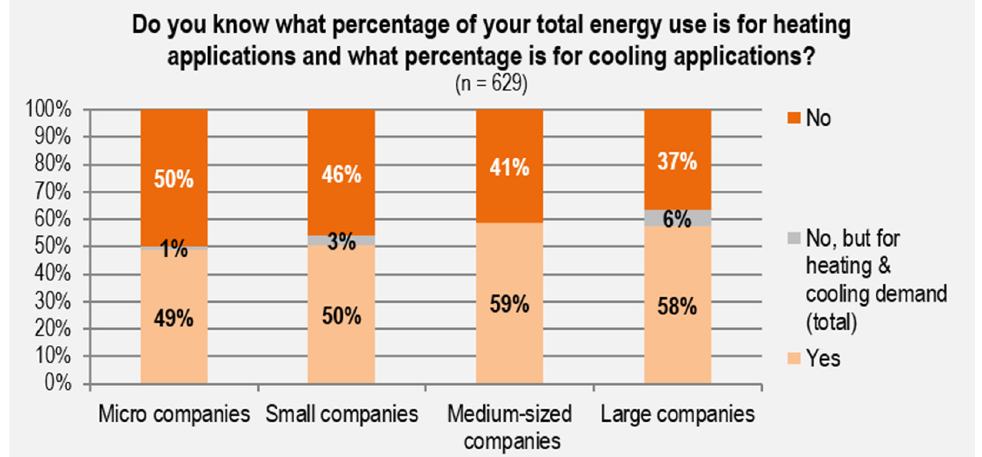
Figure 10. Companies’ knowledge of share of energy used for heating and cooling [42].